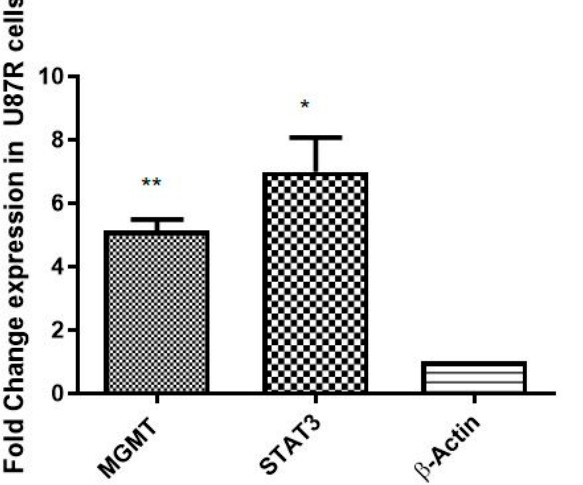
Figure 10. Fold change in expression of MGMT and STAT3 (resistance markers) in U87-S and U87-R. Each bar shows the mean ± SD values for each gene; experiments were conducted in triplicate. The results are normalized to β -actin, a housekeeping gene, and are expressed as a change from their respective controls. The level of significance is ** p ≤ 0.01, * p ≤ 0.05.